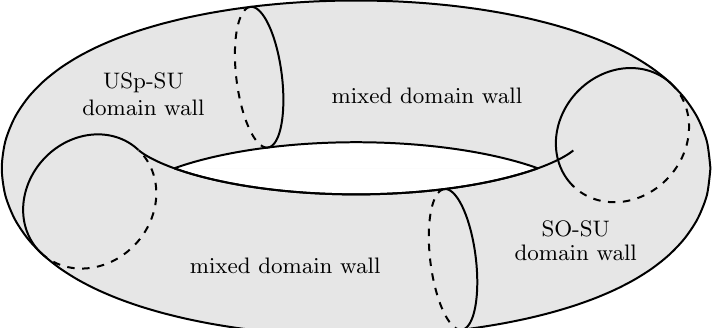
Figure 1 . Example of a 4d theory on a torus constructed from a USp-SU domain wall (3.15a) and a SO-SU domain wall (3.15b) such that both are glued to two mixed domain walls